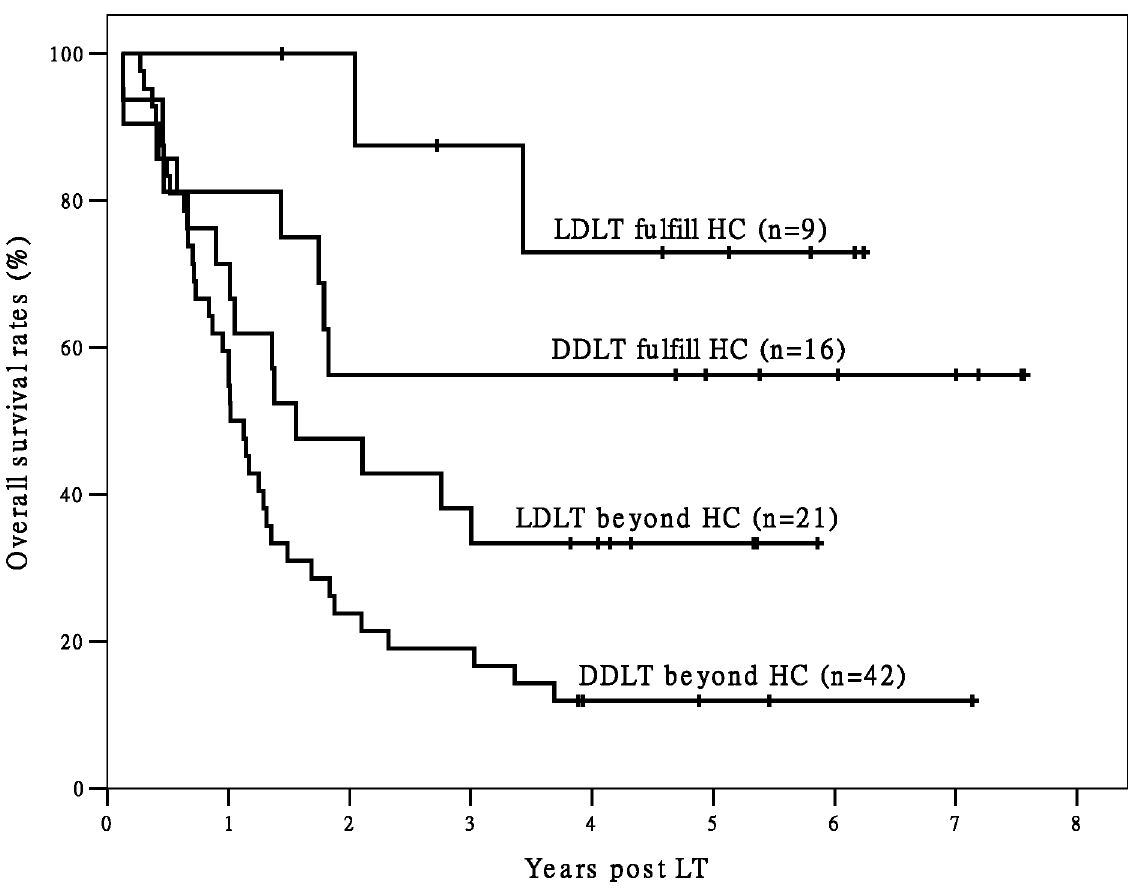
Figure 3. The survival curves of post-LT OS of recipients beyond Milan criteria. There are significant differences in OS between LDLT/ DDLT recipients fulfilling Hangzhou criteria and LDLT/ DDLT recipients exceeding Hangzhou criteria in all recipients beyond Milan criteria (both P , 0.05). Abbreviation: HC, Hangzhou criteria; OS, overall survival; LDLT, living donor liver transplantation; DDLT, deceased donor liver transplantation;